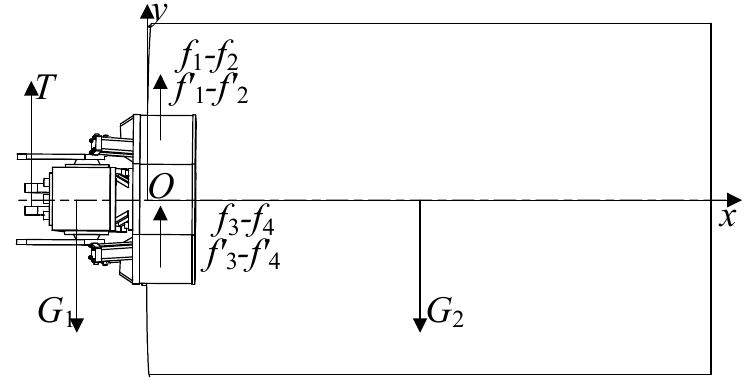
Figure 6. Force Condition during Installation and Positioning of Spreader.